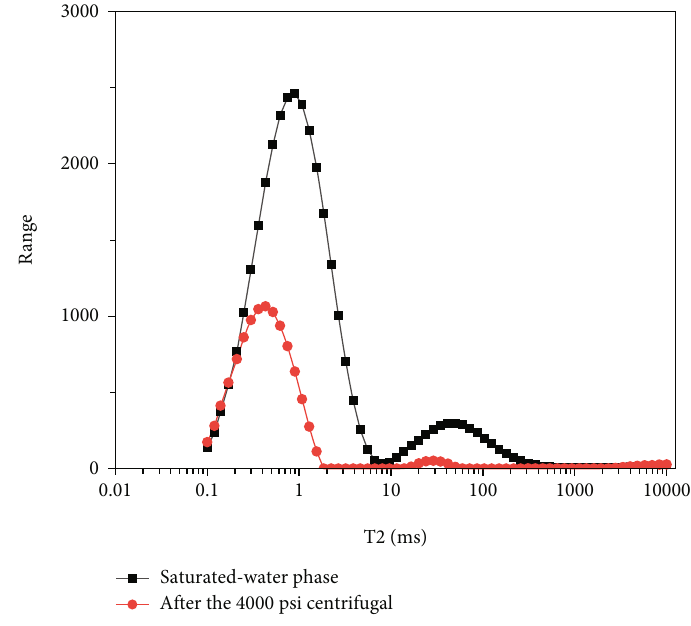
Figure 16: T2 distribution of L1-1 before and after